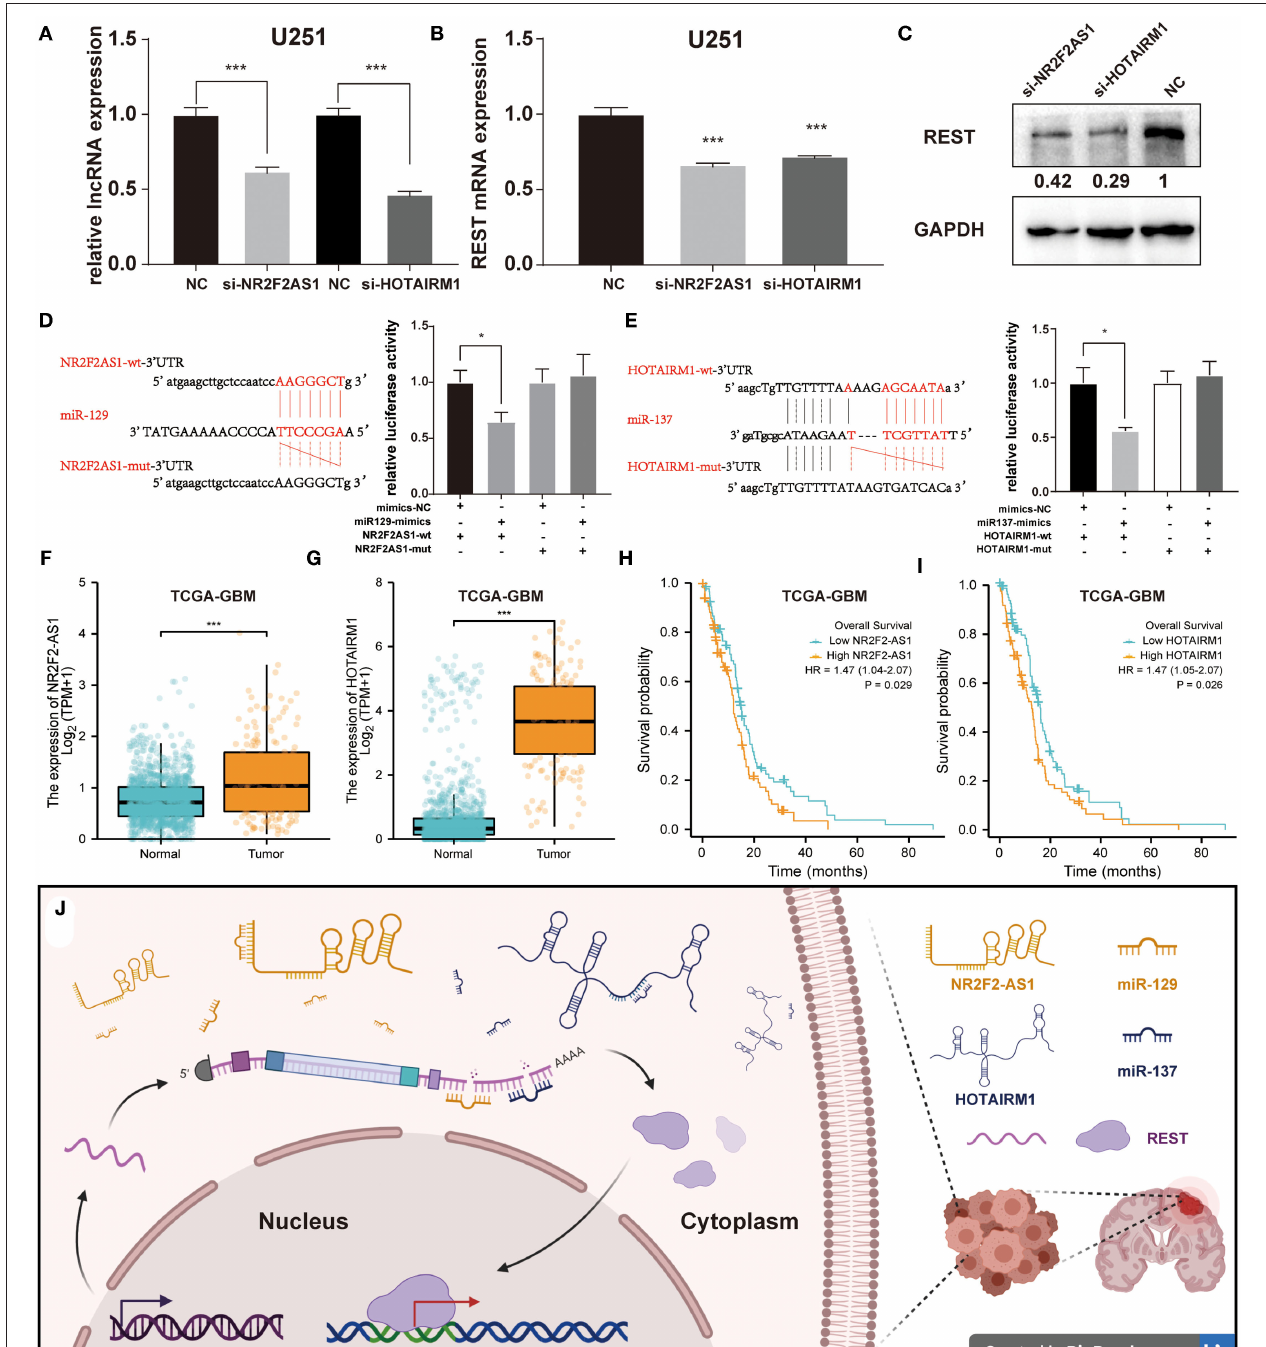
FIGURE 8 | Experimental validation between REST, miRNA, and lncRNAs. (A) The relative LncRNA expression levels after transfection of si-lncNR2F2-AS1 and si-lncHOTAIRM1. The expression levels of REST mRNA (B) and protein (C) were determined by qPCR and Western Blot. (D,E) The binding site of miRNAs in relative lncRNAs were predicted by Starbase and validated by luciferase assay. (F,G) The differential expression analysis of lncRNA between glioma samples in TCGA-GBM database and normal brain samples from TCGA and GTEx databases. (H,I) Prognostic analysis of lncRNA expression and overall survival. (J) The mechanistic scheme of lncRNA-miRNA-REST in glioma. All data are shown as mean ± SD, * P < 0.05 and *** P < 0.001. The picture was created with BioRender.com.